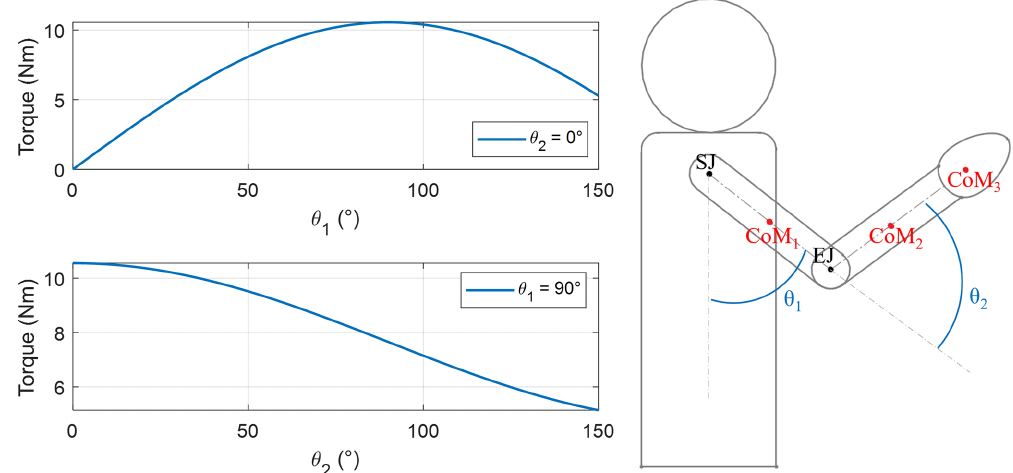
Figure 1. Torque due to gravity with respect to the elevation angle of the upper arm θ 1 and the forearm flexion angle θ 2 . SJ and EJ represent the glenohumeral (shoulder) joint center and the elbow joint center, respectively, whereas CoM 1 , CoM 2 , and CoM 3 are the centers of mass of upper arm, forearm, and hand.